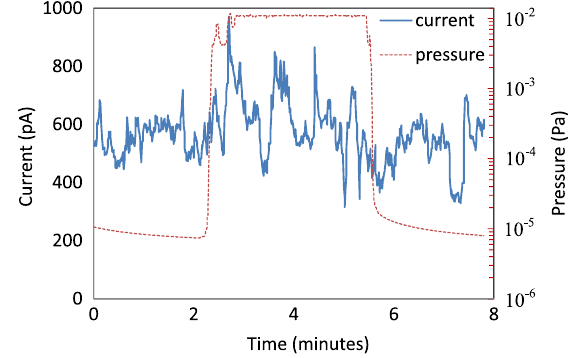
FIG. 7. Field emission current with helium injection followed by interrupted current recovery: 2 cm gap distance, 30 kVapplied